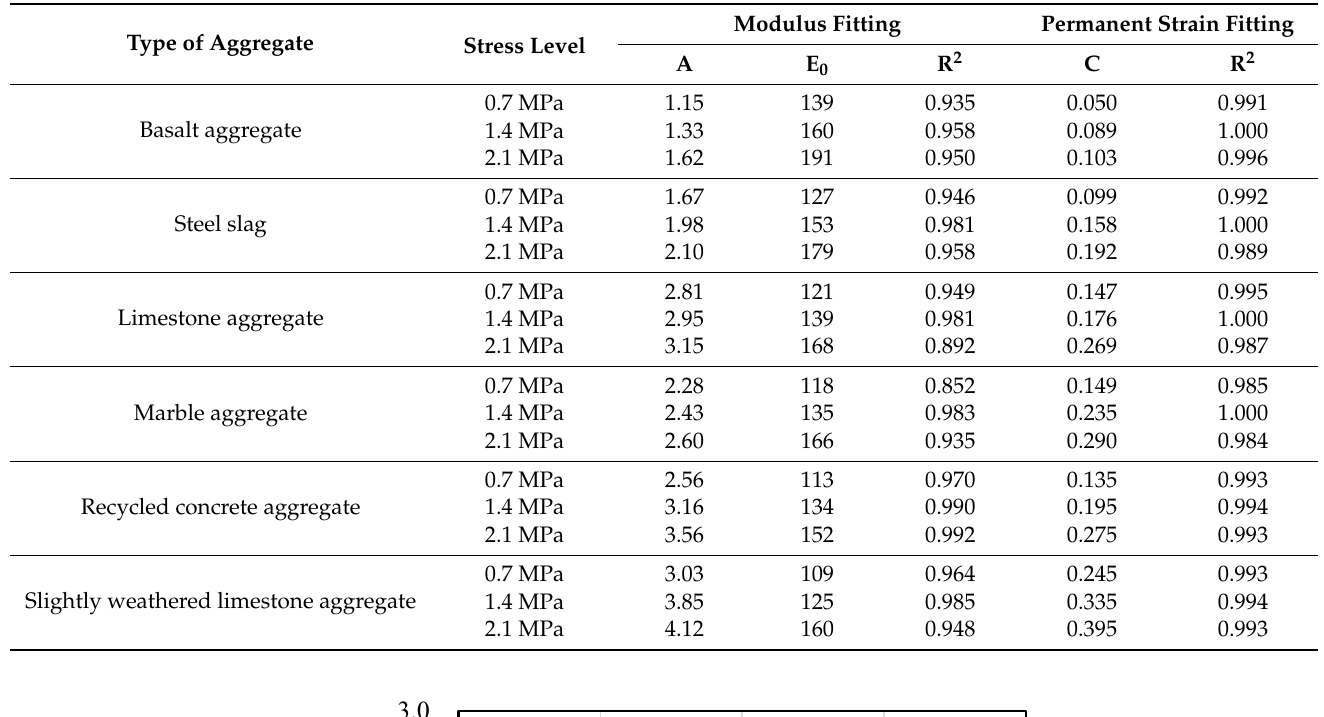
Table 4. Fitting results of model parameters for the development of resilient modulus and the accumulative permanent strain.